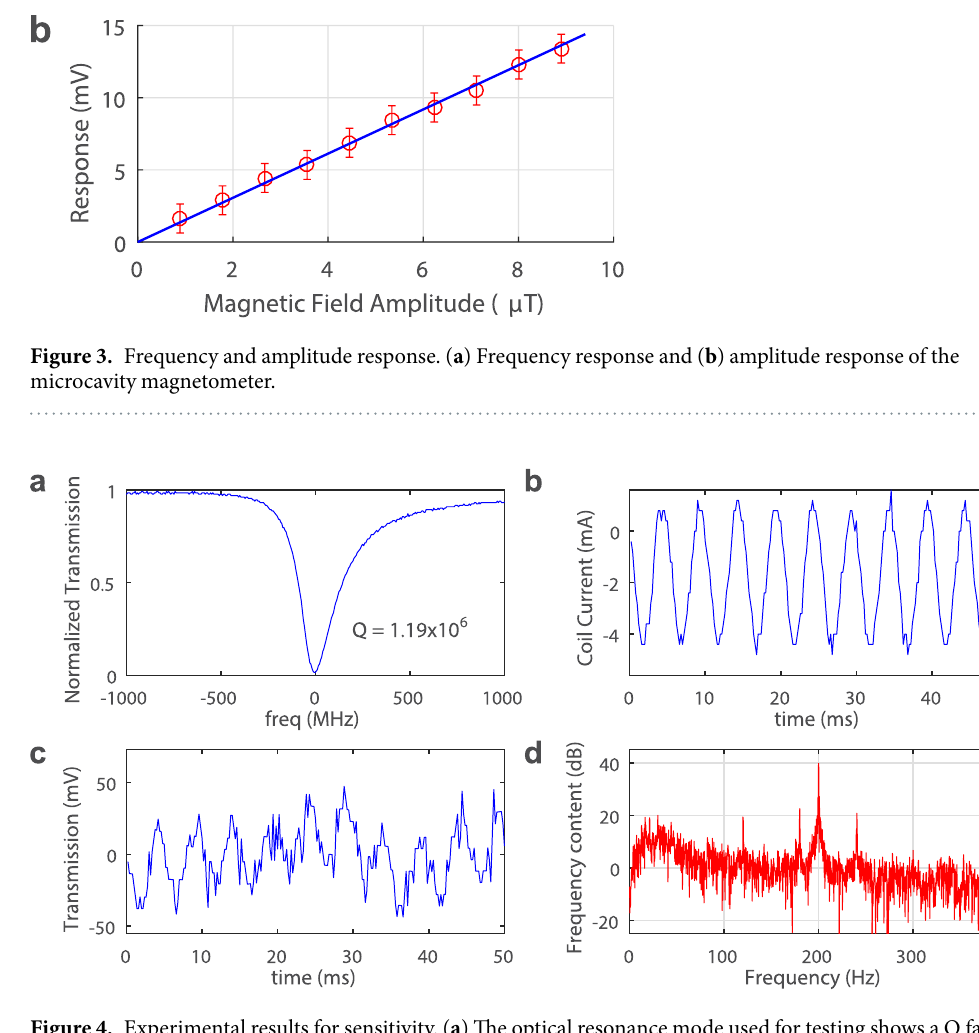
Figure 4. Experimental results for sensitivity. ( a ) The optical resonance mode used for testing shows a Q factor of 1.19 × 10 6 . Laser wavelength is 980 nm. ( b ) Oscillating Coil current with amplitude of 2.5 mA. ( c ) Measured response from the microcavity magnetometer. ( d ) Power spectrum of the magnetometer signal showing a peak at 200 Hz with SNR of about 39 dB. Time domain data acquiring window is 1